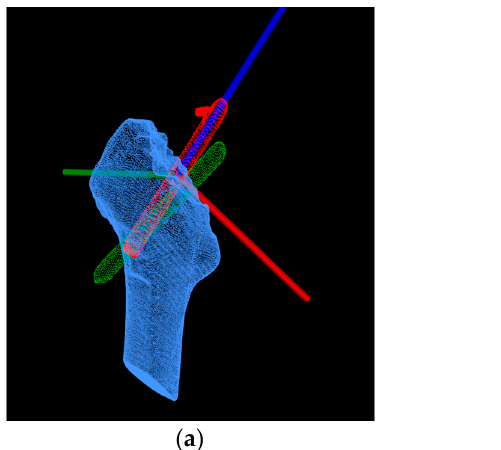
Table 4. Time consumed for different size point cloud